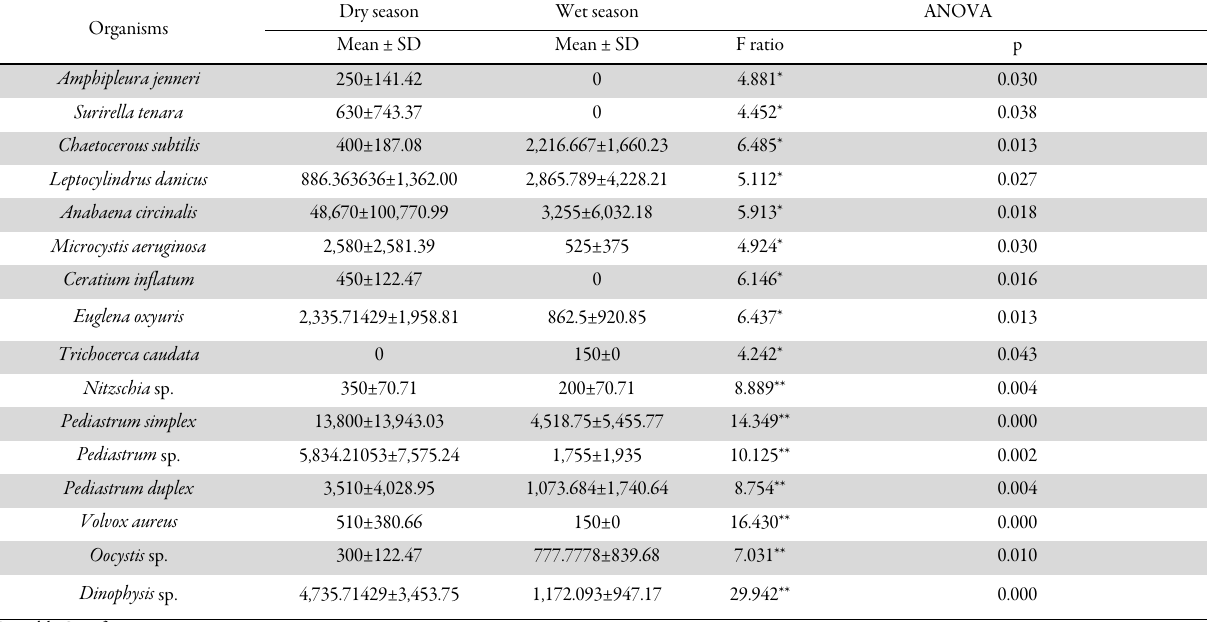
Table 4. ANOVA statistics showing significant seasonal variation among phytoplankton species